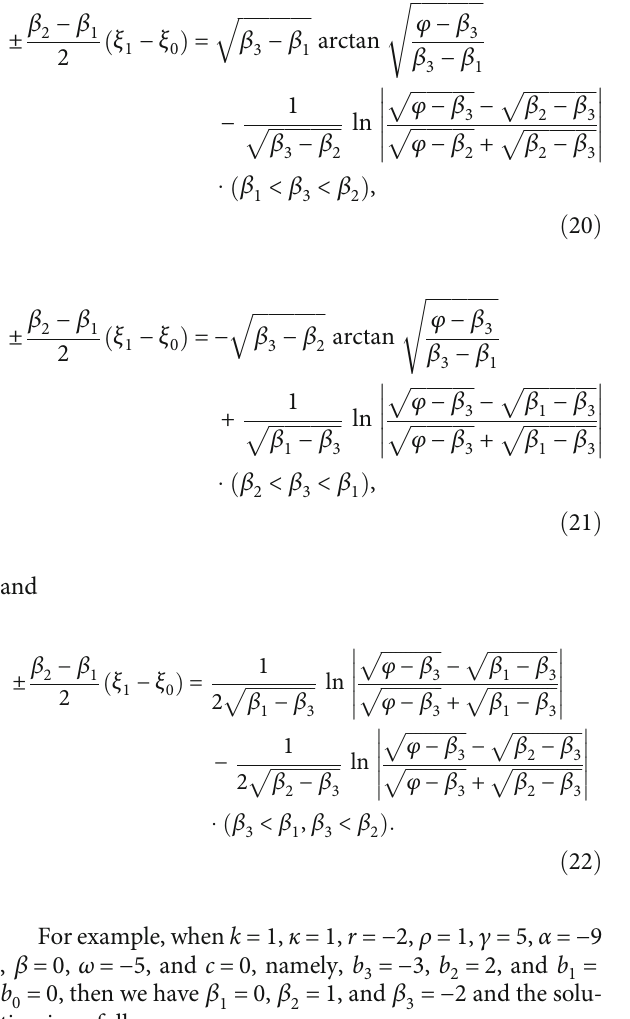
ffiffiffiffiffiffiffiffiffiffiffiffiffiffi 1 ffiffiffiffiffiffiffiffiffiffiffiffiffiffi